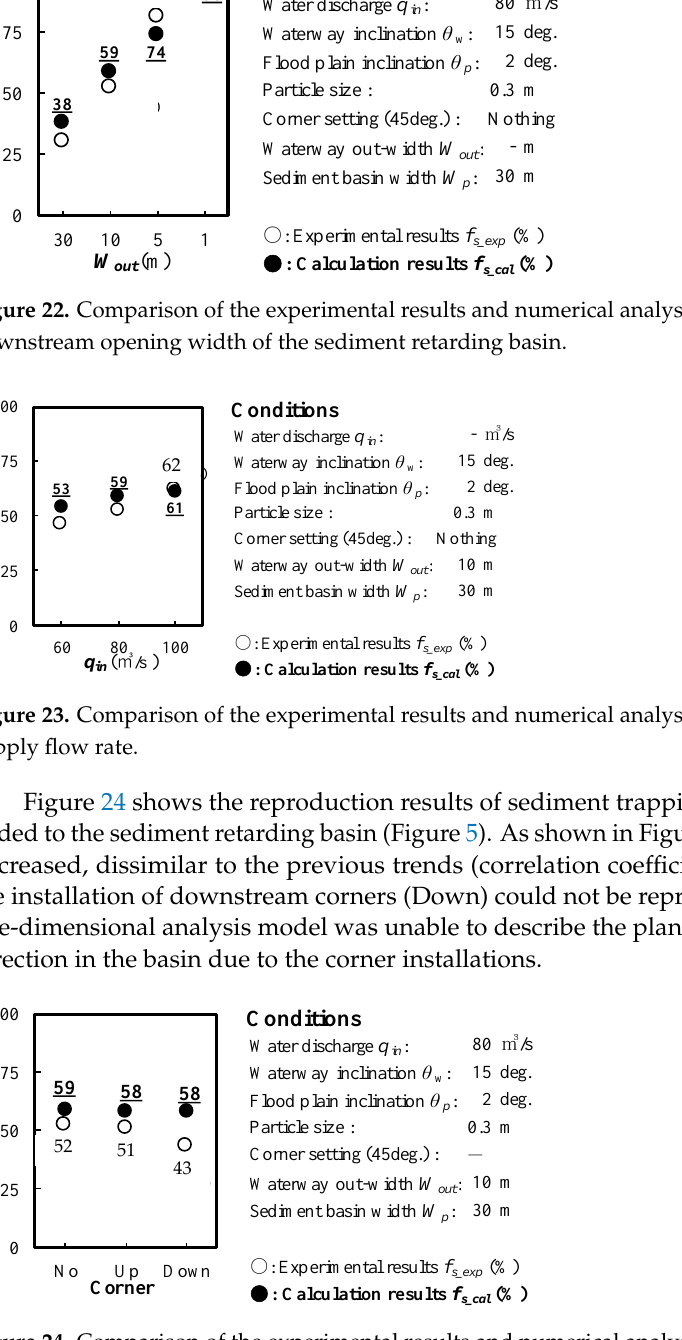
Figure 24. Comparison of the experimental results and numerical analysis results for differences in corner installations.